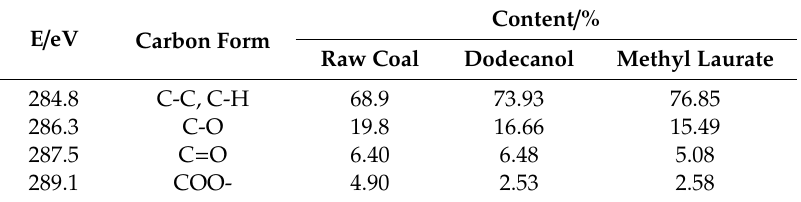
Table 9. Relative contents of carbon forms on the coal surface before and after the adsorption of